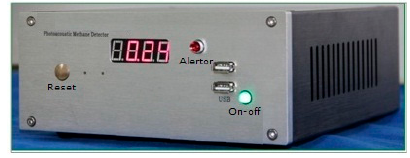
Figure 2. The photograph of this PA methane sensor.